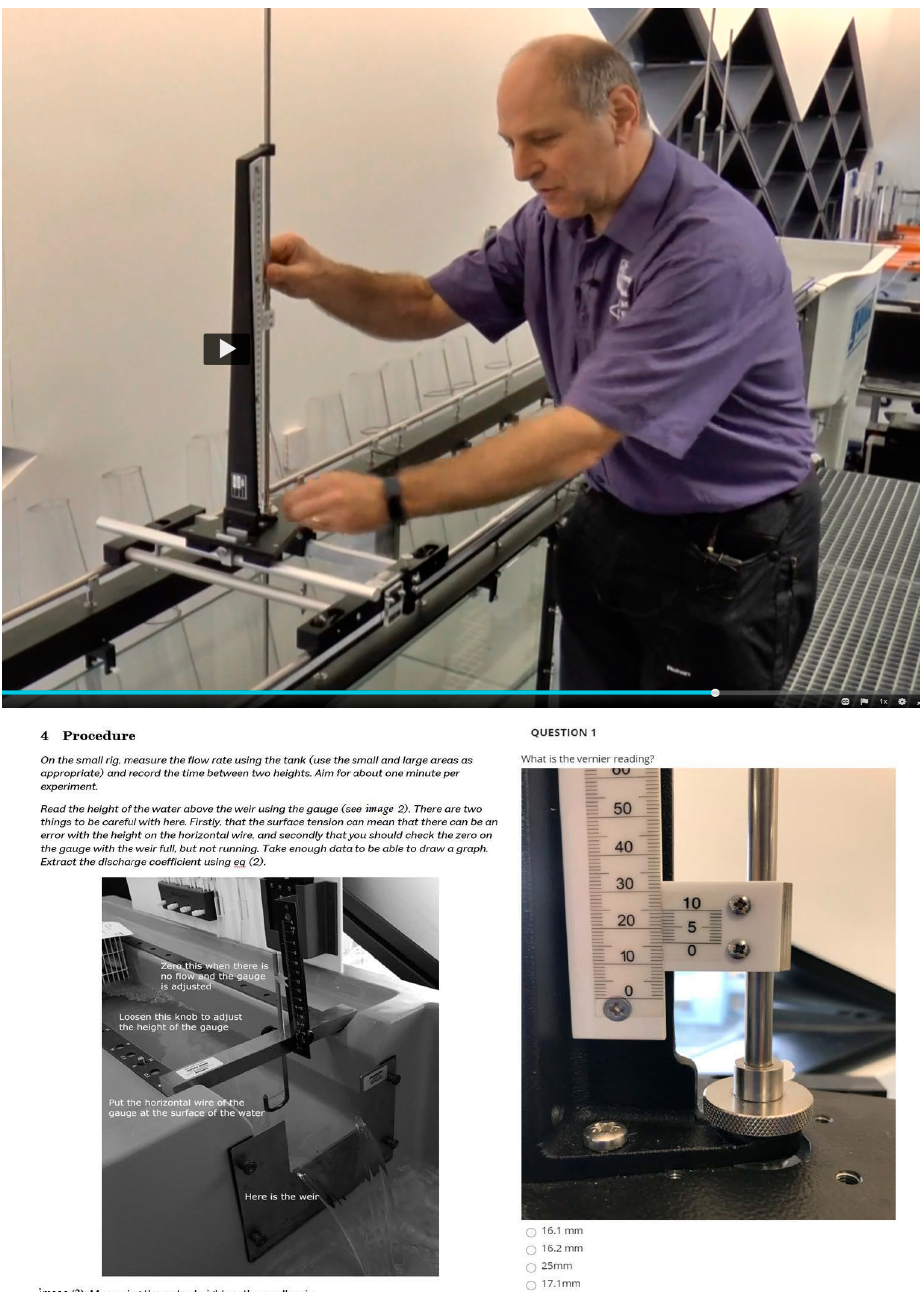
Figure 3. Examples of instructional material, including pre-experimental videos, provided to students.